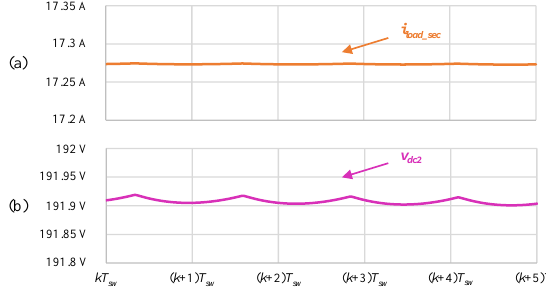
Figure 4. Waveforms in the secondary side resistive load when the SAB operates under Duty-Cycle Modulation: (a) Current; (b)